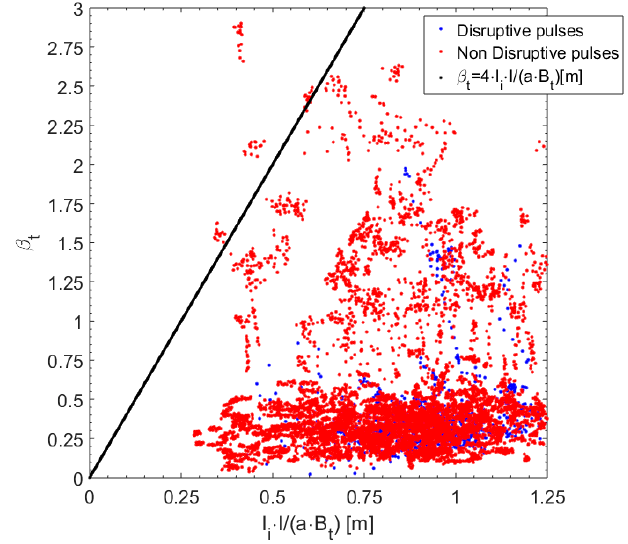
Figure 2. The beta limit plot for a large database of JET with the ILW covering campaigns C29–C30. In addition, in this space the disruptive and safe discharges overlap completely. For the non-disruptive discharges, 14 samples during the flat top are shown. For the disruptive discharges, 14 samples, taken during the 210 ms before the beginning of the current quench, are reported.